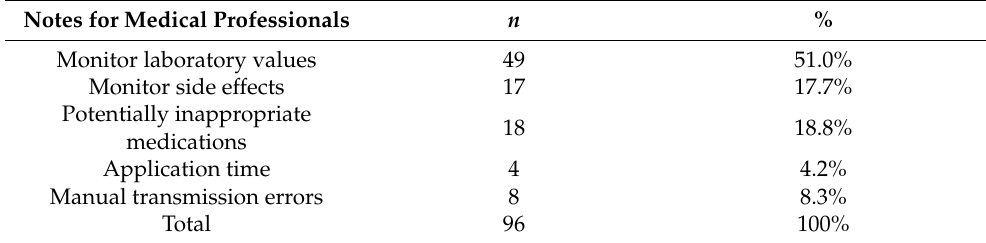
Table 4. Information provided by the clinical pharmacist to the ward physician to optimize the therapy of patients with vascular